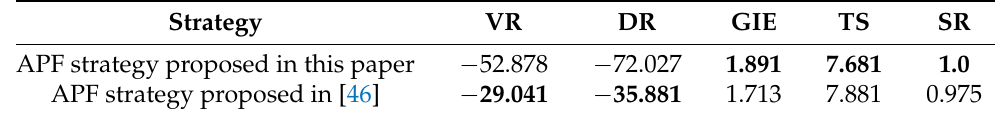
Table 1. Evaluation results under the control of the two expert strategies. The bold data represent the optimal values of different strategies on the same evaluation metric. Same as the tables